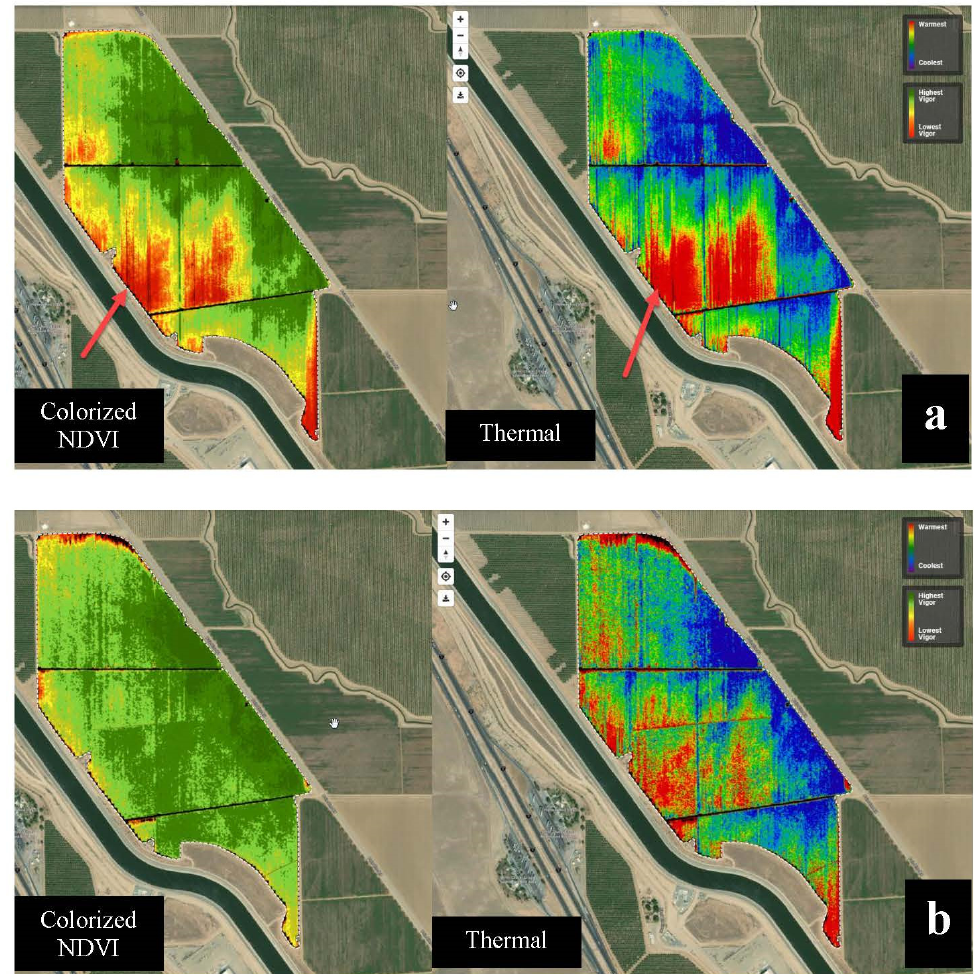
Figure 3. Remote-sensing imagery-based IDSS provided by Ceres Imaging Inc. (Oakland, CA, USA) for evaluating distribution uniformity using colorized NDVI and thermal maps. ( a ) Warmest areas of the field were under water stress and showed lowest vigor at early crop growth stage because of low dripline pressure due to topographical differences; ( b ) Increased pressure of driplines after identifying the stress led to more uniform distribution of water application with homogenous crop vigor saving an estimated yield worth USD 20,000.